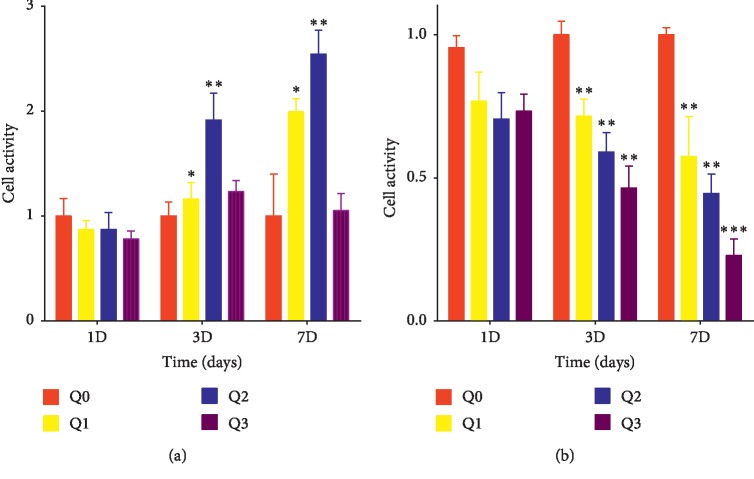
Effect of composites on the activity and cell viability of (a) murine osteoblast cell line MC3T3-E1 and (b) human osteosarcoma cell line MG-63 treated with the composite extracts for 1, 3, and 7 days. Cell viability was assayed using the CCK-8 method. Each experiment was repeated three times. ∗p < 0.05 compared with Q0.